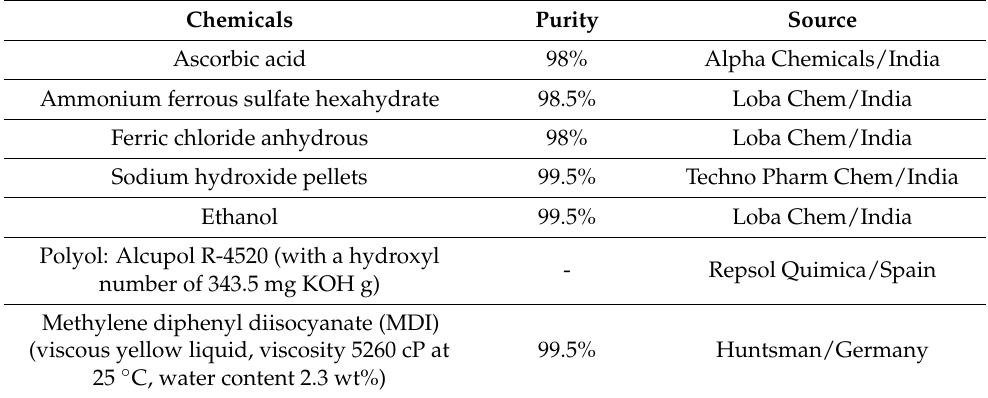
Table 1. Cont. Chemicals Purity Source Ascorbic acid 98% Alpha Chemicals/India Ammonium ferrous sulfate hexahydrate 98.5% Loba Chem/India Ferric chloride anhydrous 98% Loba Chem/India Sodium hydroxide pellets 99.5% Techno Pharm Chem/India Ethanol 99.5% Loba Chem/India Polyol: Alcupol R-4520 (with a hydroxyl - Repsol Quimica/Spain number of 343.5 mg KOH g) Methylene diphenyl diisocyanate